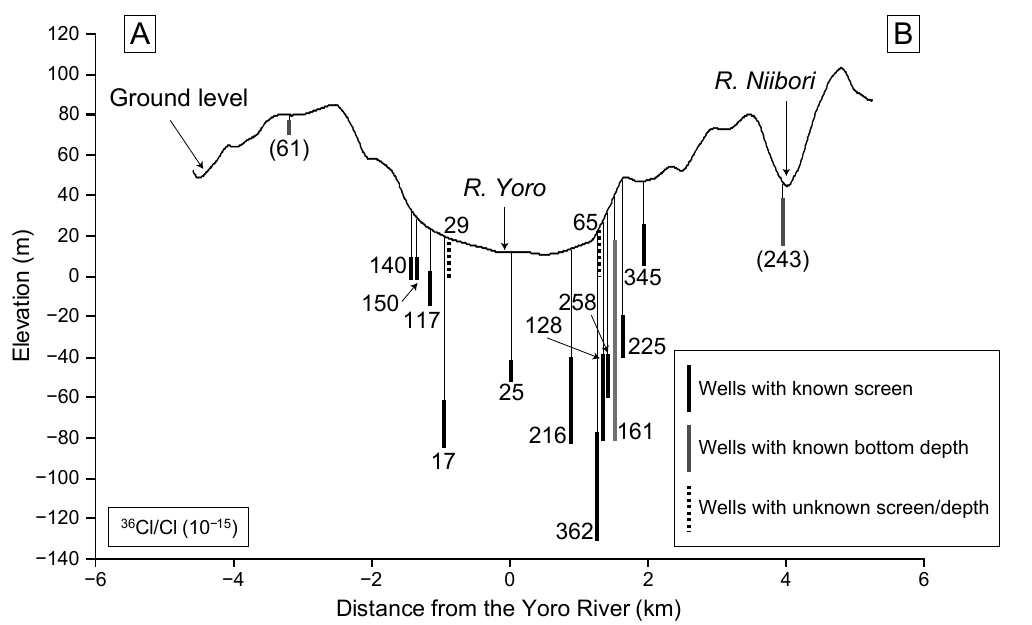
Figure 8. Cross-sectional distribution of 36 Cl/Cl values in the Yoro River basin. Parentheses indicate samples with high NO